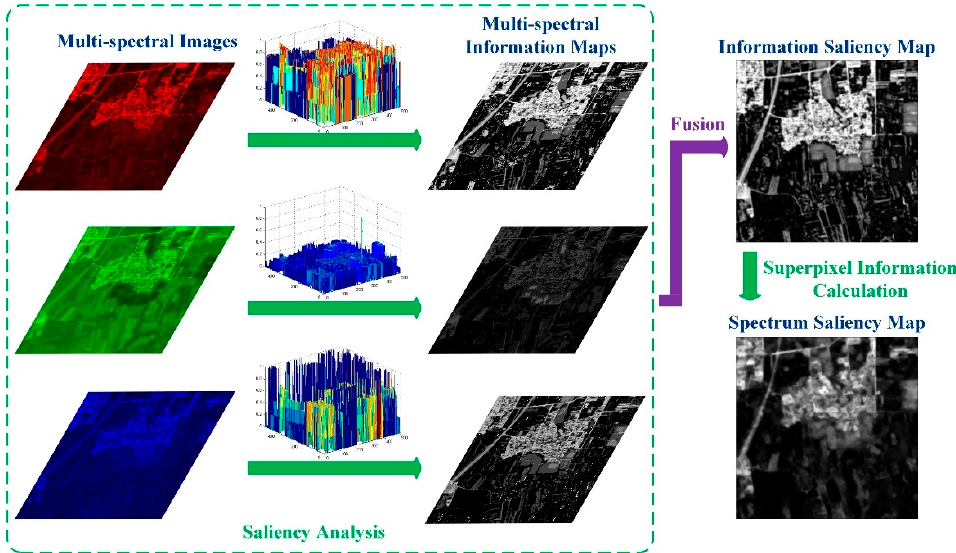
Figure 4. Intra-spectrum information distribution estimation.